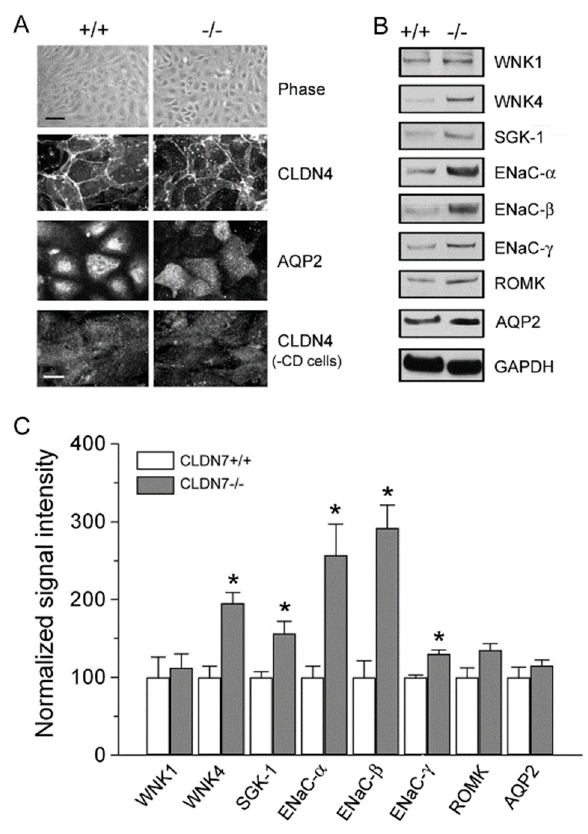
Figure 4. Deletion of CLDN7 had a significant effect on protein expression levels of representative kinases and ion channel on primary CD cells. ( A ) The establishment of primary cultures of CD cells isolated from kidneys of CLDN7 +/+ and CLDN7 − / − pups. The top panel shows the phase images of primary CD cells isolated from kidneys of 5-day old CLDN7 +/+ and CLDN7 − / − pups after cultured in 12-well plates for a week to form a complete monolayer. Bar: 40 µm. The cultured primary CLDN7 +/+ and CLDN7 − / − CD cells were immunostained with anti-CLDN4 and anti-AQP2 antibodies. The last panel shows the remaining cells immunostained with anti-CLDN4 antibody after removal of CD cells. Bar: 15 µm. ( B ) The primary CD cells were lysed in RIPA buffer and a total of 30 µg protein for each lane was loaded onto the SDS NuPAGE gel. Membranes were blotted against WNK1, WNK4, SGK-1, ENaC- α , - β , and - γ , ROMK, and AQP2. GAPDH was used as a loading control. ( C ) Densitometry analysis of protein expression levels shown on ( B ). Each band intensity for CLDN7 +/+ CD cells was normalized and set as a reference. * p < 0.05. n = 4.